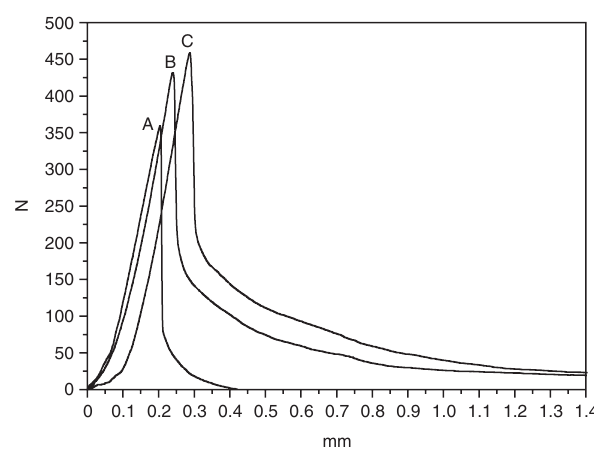
Figure 6: Stress-strain curves of the plain sample (A), non-treated FRCCs (B), and treated FRCCs (C), obtained from the flexure